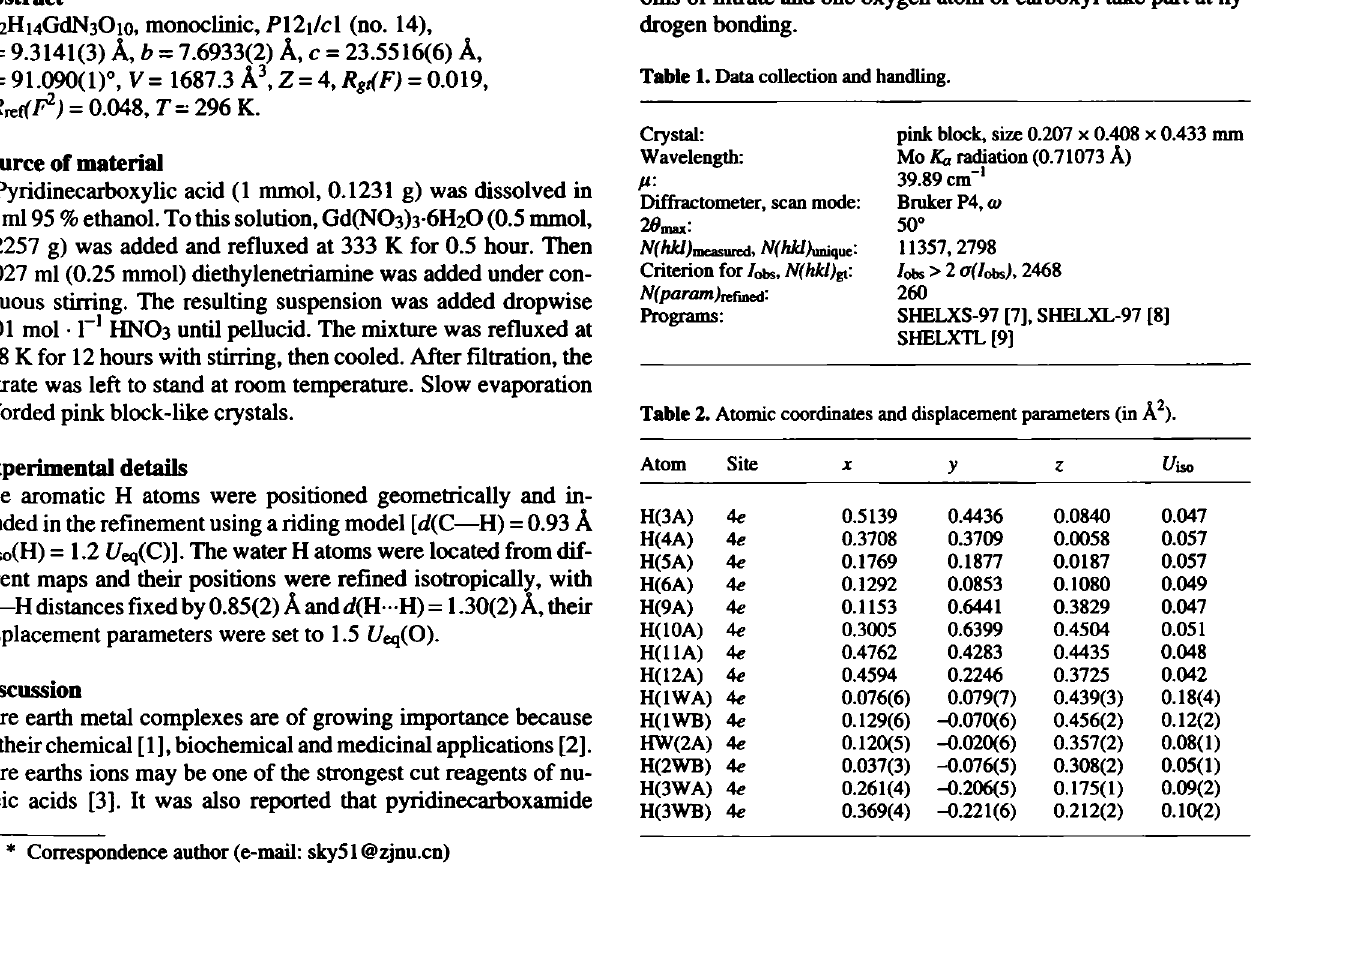
Table 2. Atomic coordinates and displacement parameters (in Â 2